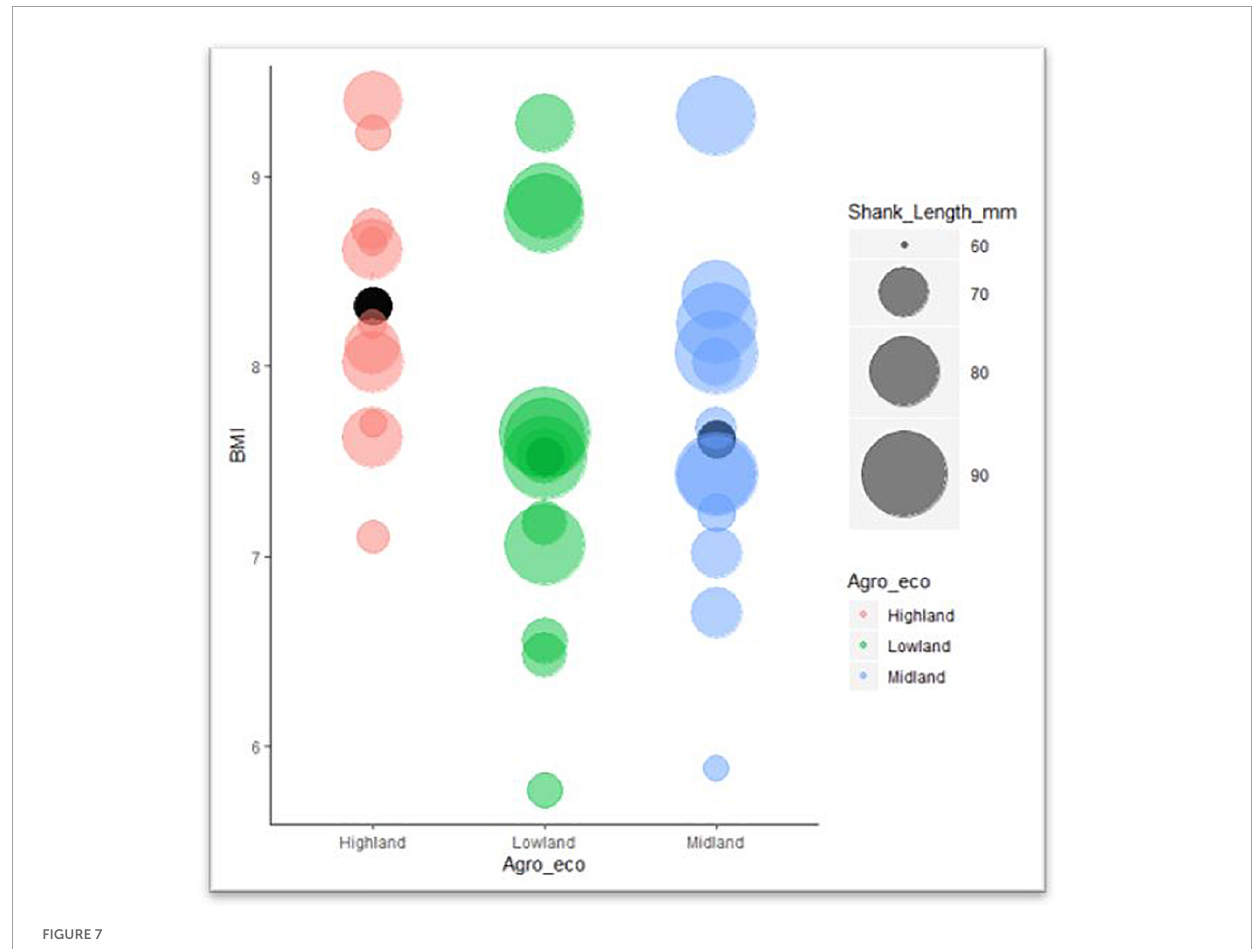
FIGURE7 Bubble graph of BMI and shank length for indigenous chicken.